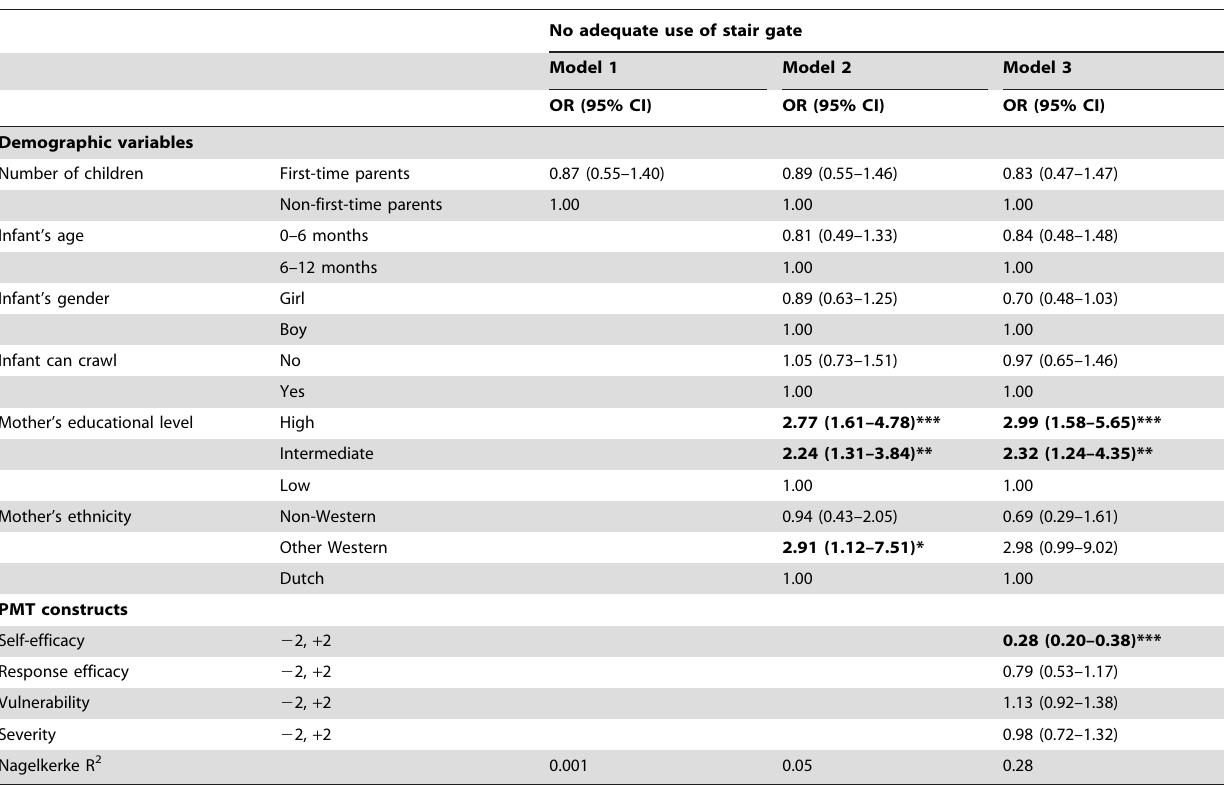
Table 4. Odds ratios (OR) and 95% confidence intervals from multiple logistic regression analyses with no adequate use of the stair gate as dependent variable and number of children (Model 1), other demographic variables (Model 2) and Protection Motivation Theory (PMT) variables (Model 3) as independent factors in a subgroup of parents with a stair gate present at their staircase (n=590).